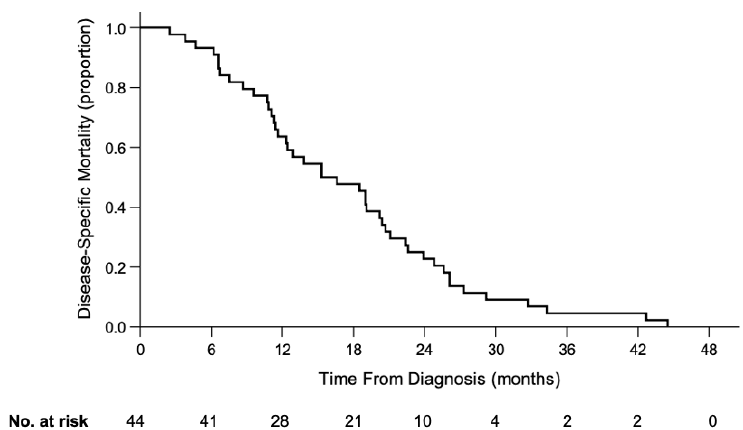
Figure 3. Kaplan-Meier curve of disease-specific survival of 44 patients who received no treatment. The median time from orbital disease to death was 4.7 (range, 1.7–19.2) months and the median time from metastatic disease to death was 2.0 (range, 0.4–10.1) months. Children with initial brain metastasis had shorter survival times than those with initial nonbrain metastasis (median 1.0 vs. 3.1 months; p = 0.015). At the time of death, periorbital